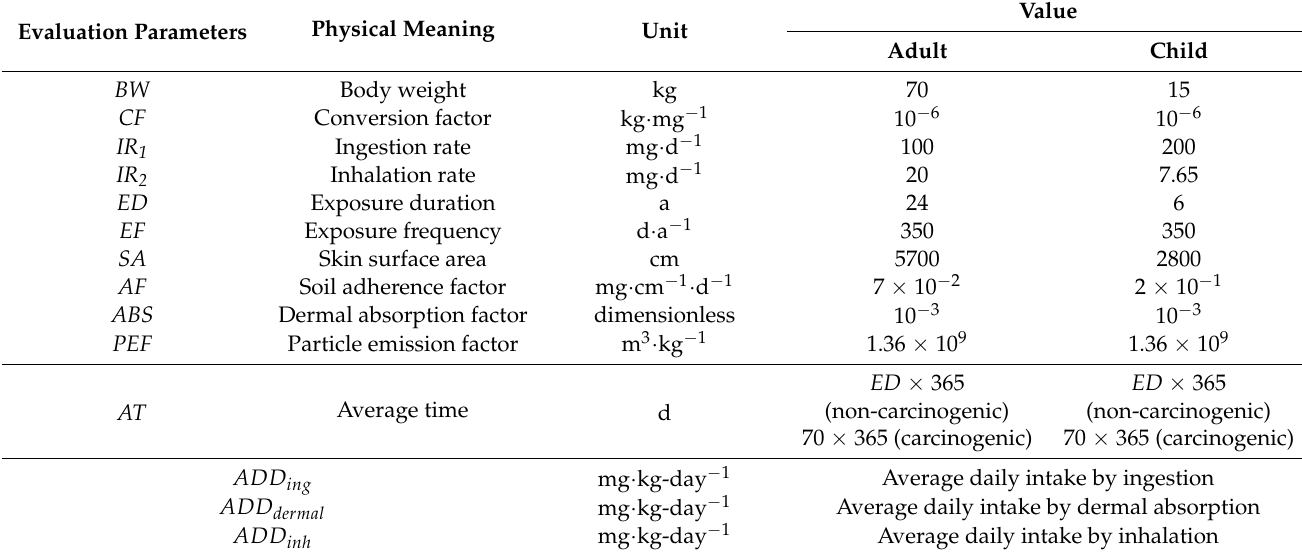
Table 2. Parameters of the human health risk assessment